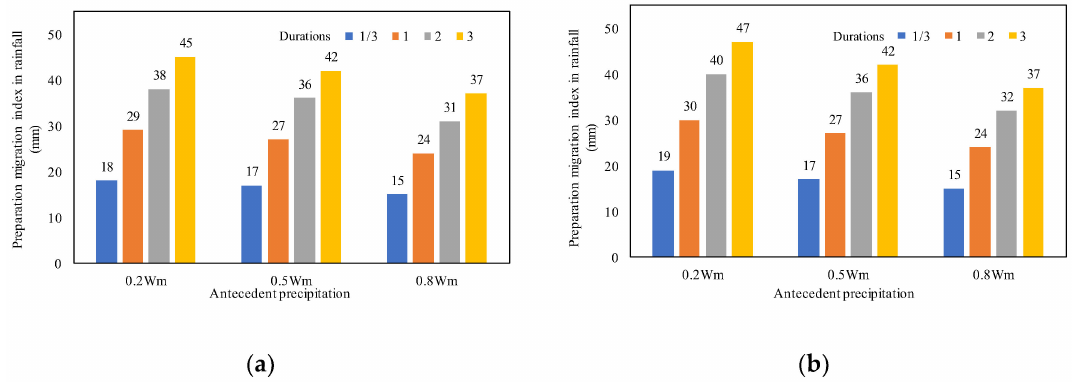
Figure 14. Preparation for migration index in rainfall with different antecedent precipitation and durations (hours): Anding ( a ), Qiangjiawan ( b